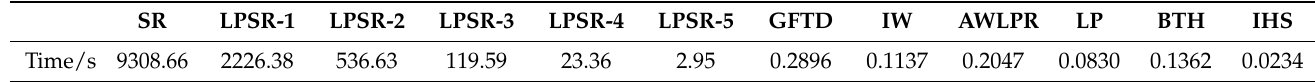
Table 5. Running time (in seconds) of the proposed method with different LP levels.